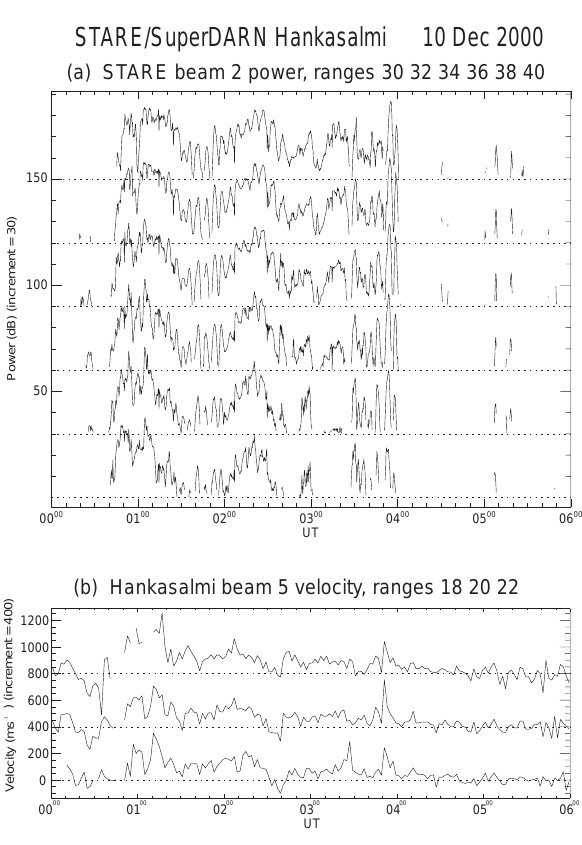
Fig. 17. Stacked STARE Norway radar backscatter power from beam 2 and range gates 30, 32, 34, 36, 38 and 40 (a) , and stacked SuperDARN Hankasalmi radar beam 5 velocity from range gates 18, 20 and 22, between 00:00UT and 06:00UT on 10 December 2000 (b) .